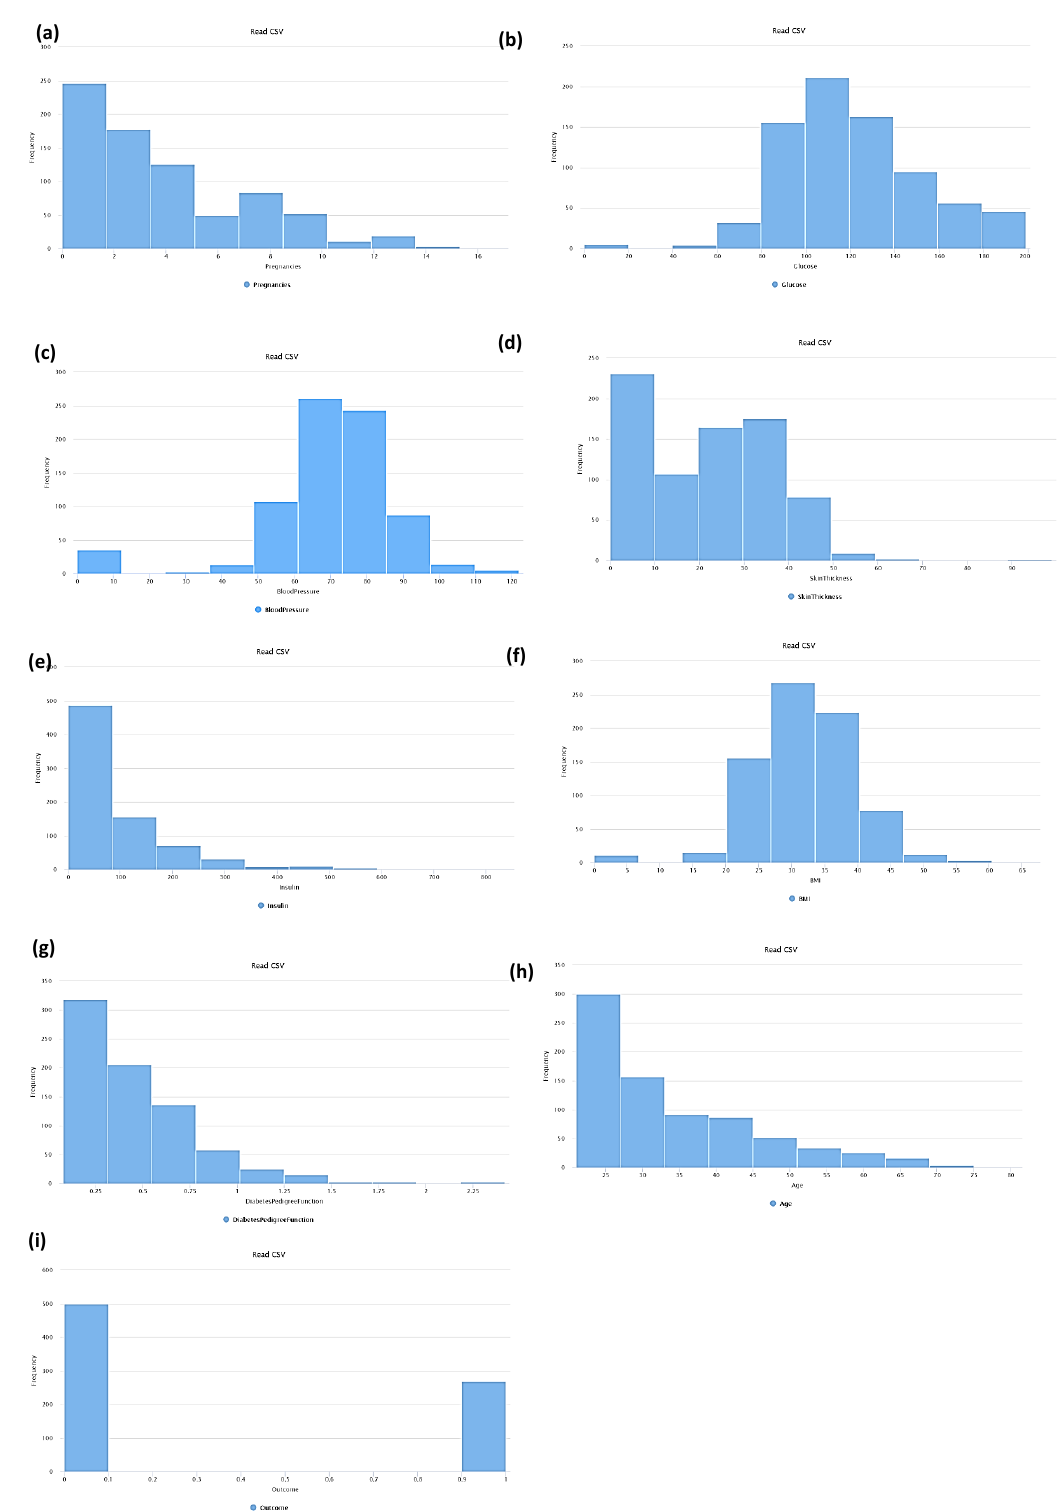
Figure 2. ( a – i ) Attribute dataset statistic distribution.